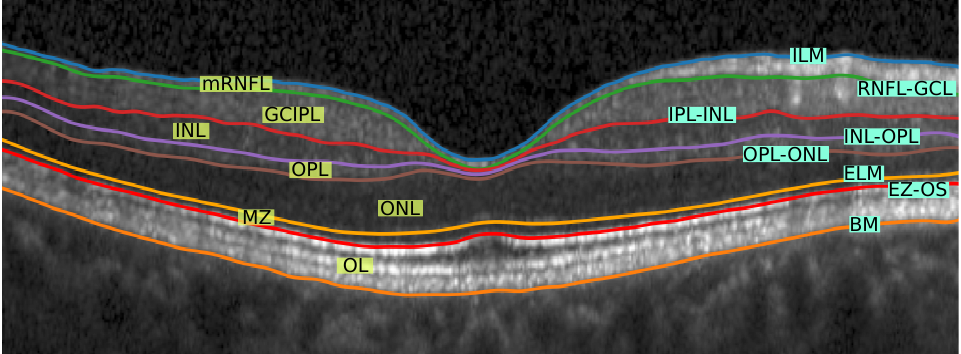
Figure 2. Visual representation of different retinal layers and boundaries after segmentation. Our method segments 9 different regions (7 highlighted with yellow background on the left side of the image and other two region are: above ILM and below BM) from 8 different retinal boundaries (high- lighted with cyan background on the right side of the image). Layer abbreviations are positioned within their respective layer; boundary abbreviations are positioned on top of their respective